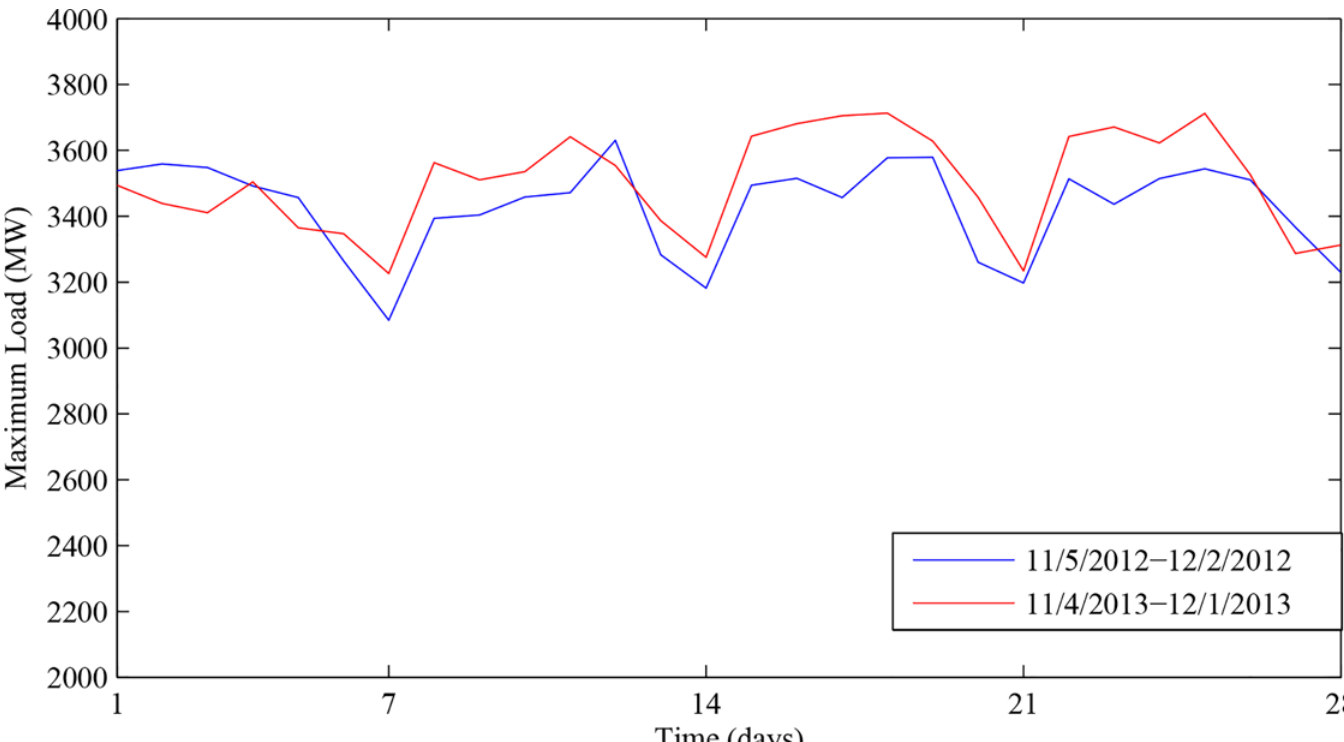
Fig 1. The week characteristic of daily maximum load. The blue line represents the maximum load from November 5th of 2012 to December 2nd of 2012. The red line represents the maximum load from November 4th of 2013 to December 1st of 2013.